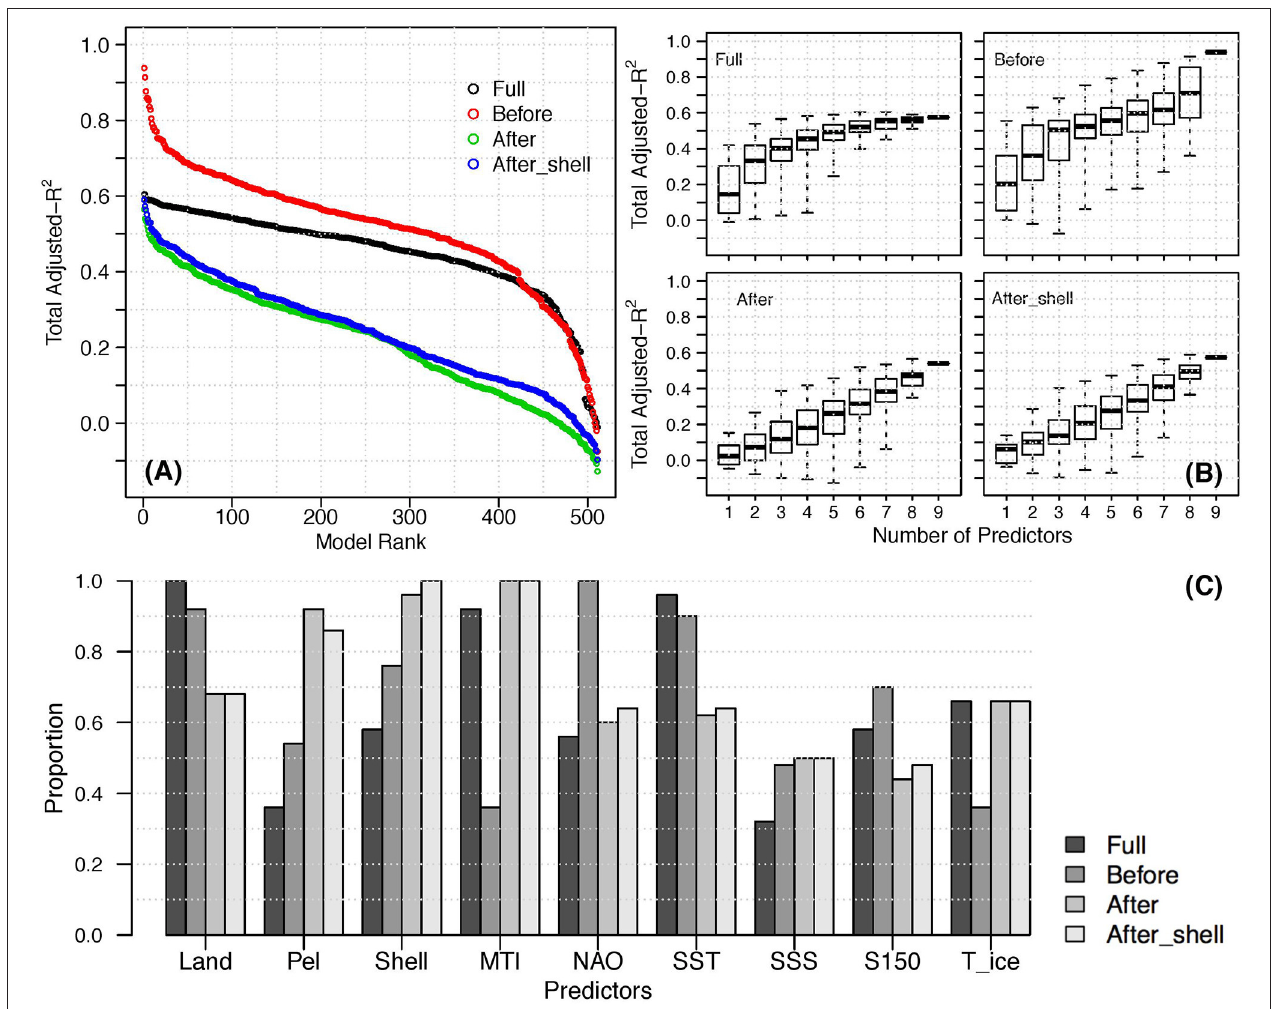
FIGURE 5 | (A) Adjusted-R 2 Total for zero-delay indicators of the three time periods; (B) The range of adjusted-R 2 Total for a given number of predictors for each time period; (C) Proportion of times each predictor appeared in the top 50 models of each time period. (“After_shell” indicates analysis that included the community shellfish biomass index as a